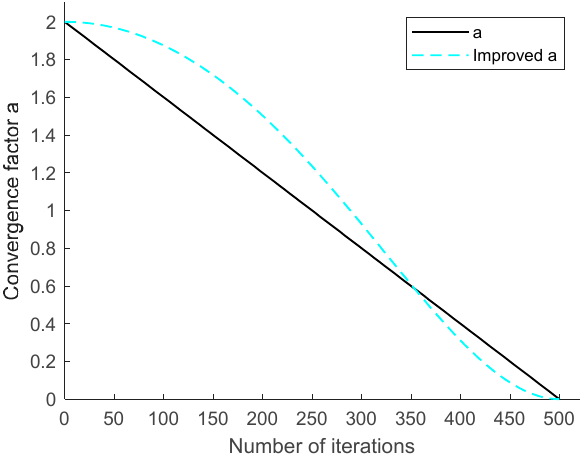
Figure 6. Graph of the variation of a with the number of iterations. The nonlinear factorial balancing strategy, to a certain extent, improves the global search performance of the algorithm, and because the value of A is affected by the random numbers in Equations (2) and (3), the local search capability of the algorithm is affected, and the line accuracy of the robot path planning is reduced. Therefore, a weighting strategy is introduced in the position update formula for global and local search of the nonlinear factors in collaboration to improve the local search capability of the algorithm, with the following specific weight expressions: